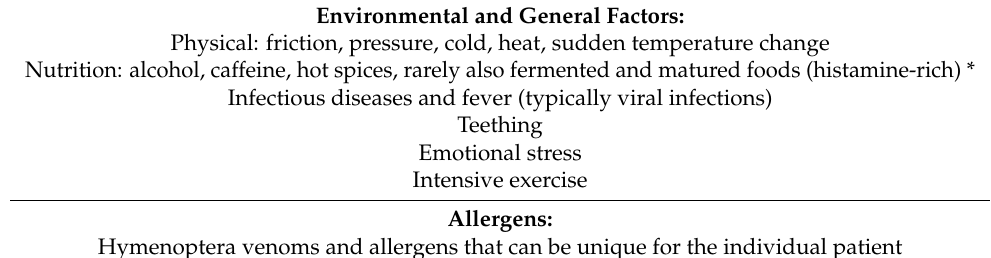
Table 3. Examples of potential triggers of mast cell activation in patients with pediatric mastocytosis. Environmental and General